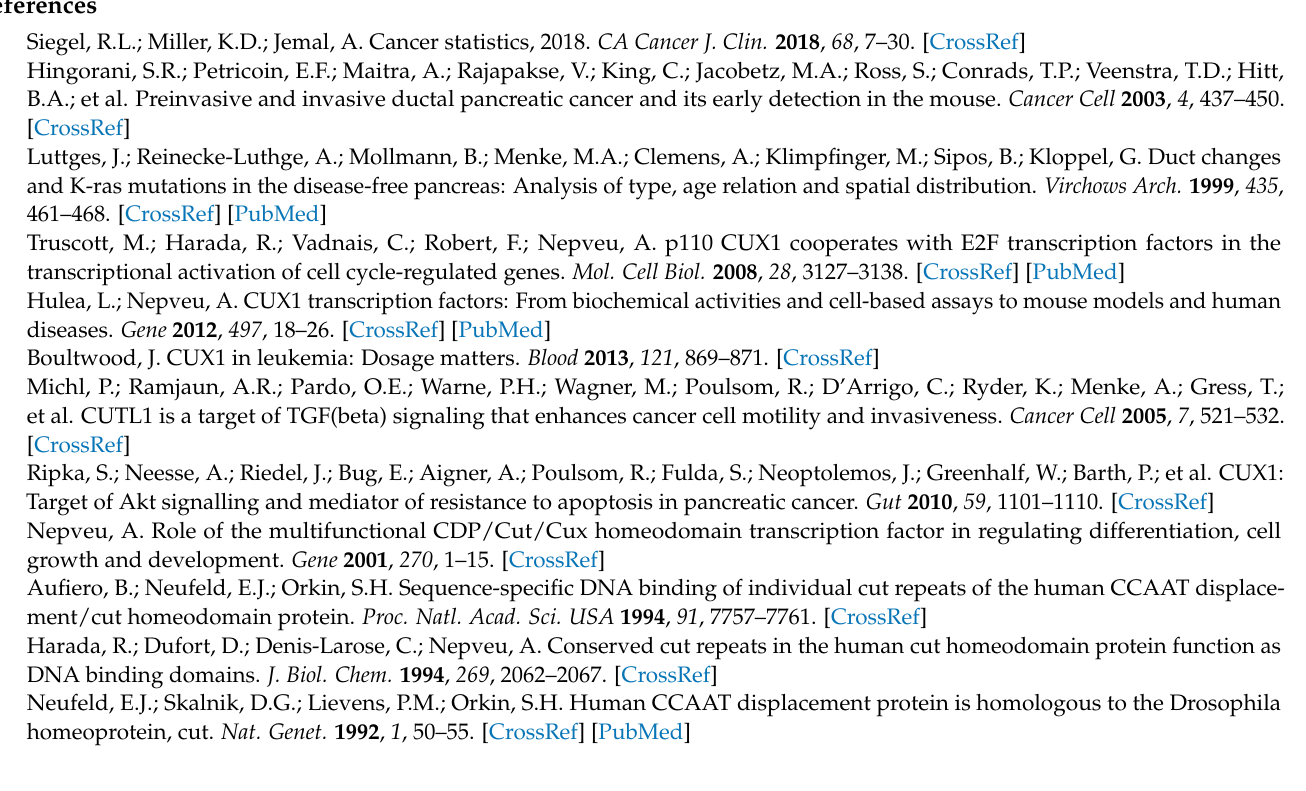
Figure S2. p200 CUX1 has no impact on survival during KRAS-driven PDAC development, Figure S3. Generation and verification of Cux1p110 mice, Figure S4. p110 CUX1 potentiates KRAS-driven proliferation during PanIN progression, Figure S5. p110 CUX1 potentiates KRAS-driven proliferation during PanIN progression, Figure S6. Expression of p110 CUX1 in p200 CUX1-overexpressing Panc-1 cells, Figure S7. p110 CUX1 mRNA expression in pancreatic cell lines, Figure S8. p110 CUX1 enhances colony formation in mutant KRAS expressing pancreatic cell lines, Figure S9. Uncropped Western Blot images, Figure S10. Densitometry analysis of Western